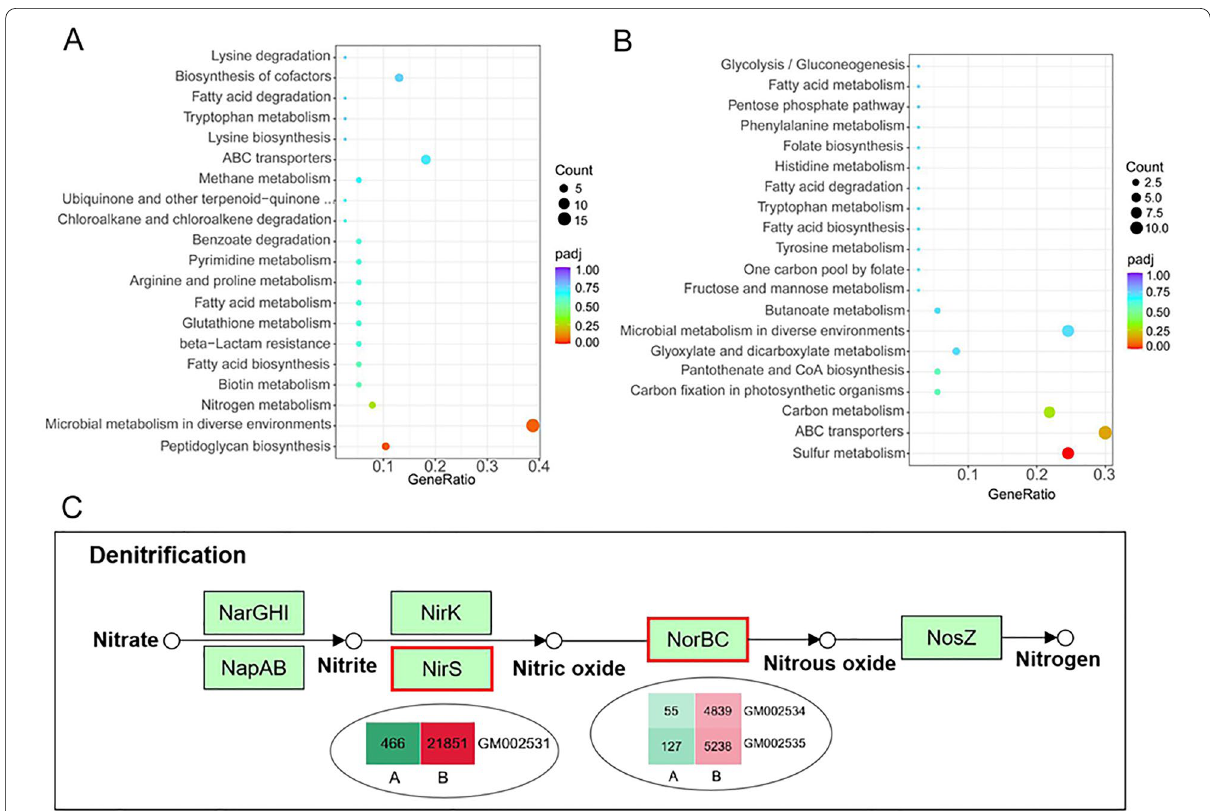
Fig. 4 KEGG pathway enrichment of DEGs in the B vs. A group. A KEGG pathway enrichment of the upregulated DEGs. B KEGG pathway enrichment of the downregulated DEGs. The size of the circle represents the number of DEGs in the pathway, and the color of the circle represents the padj value (p value adjusted to false discovery rate), reflecting the enrichment degree. C The DEGs involved in the denitrification pathway. The genes encoding enzymes in the rectangular box with a red border were significantly upregulated, and the FPKM of each gene is shown in the rectangle inside the